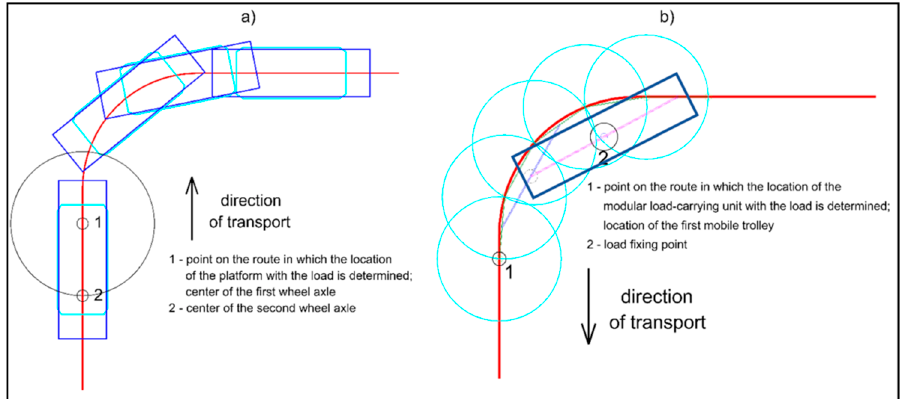
Figure 3. An example of determining the location of a transportation device with a load at a given point of a route: ( a ) for the transportation platform (floor-mounted railway); ( b ) for the modular load-carrying unit (suspended monorail).